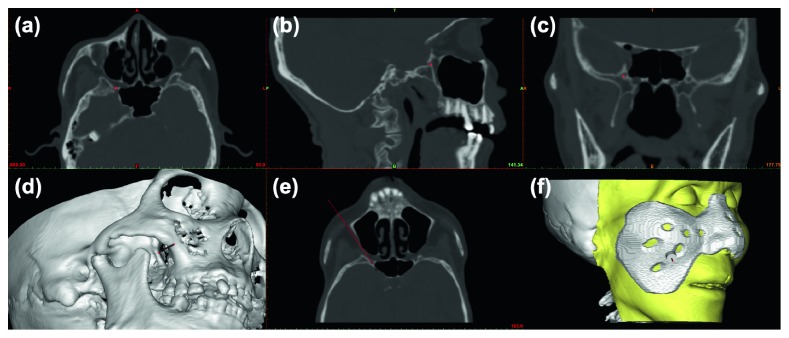
Progress of designing simulative trajectory and CAD template. We set the target at the external opening of the FR and confirm the right location (point) on the axial (a), sagittal (b), and coronal (c) views, respectively. A simulated puncture trajectory (cylinder) through the pterygopalatine fossa was then designed on the 3D image (d). The examination should be performed in the direction of the trajectory (e) with no bony structures, and paramount tissues obstruct the approach (line). After deciding the final trajectory, a template with a support bracket and a guide cannula was designed on computer software (f).